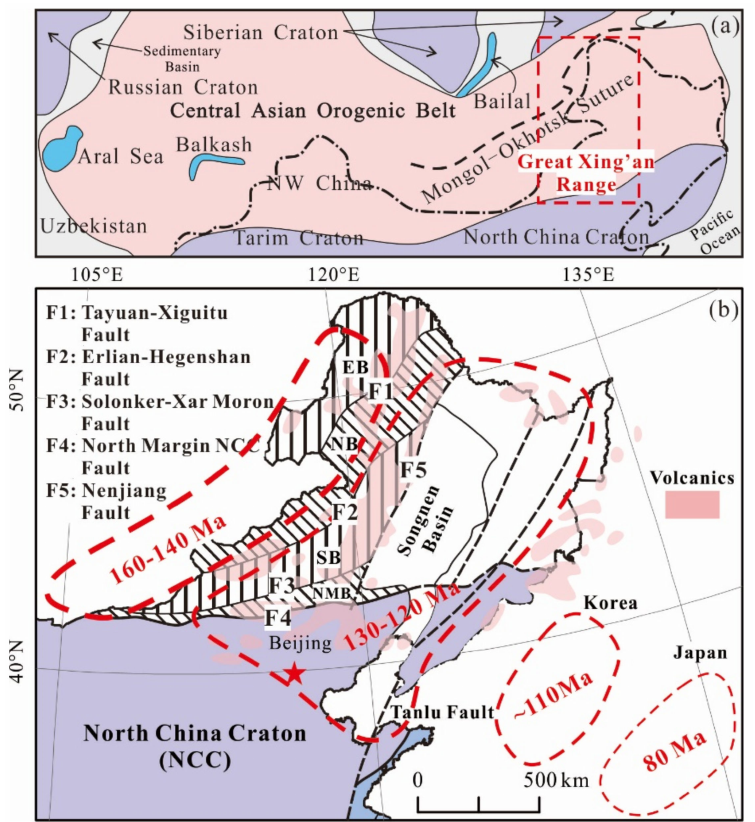
Figure 1. Geological sketch map of the Central Asian Orogenic Belt (CAOB) and Great Xing’an Range (GXR). ( a ) is after [21]. ( b ) is modified from [22]. Ages in red indicate the Pacific oceanward migration of Pacific subduction in Jurassic and Cretaceous [22]. The GXR is composed of blocks EB, NB, SB and NMB. EB, Erguna Block; NB, North Great Xing’an Range Block; SB, South Great Xing’an Range Block; NMB, North Margin Block of North China